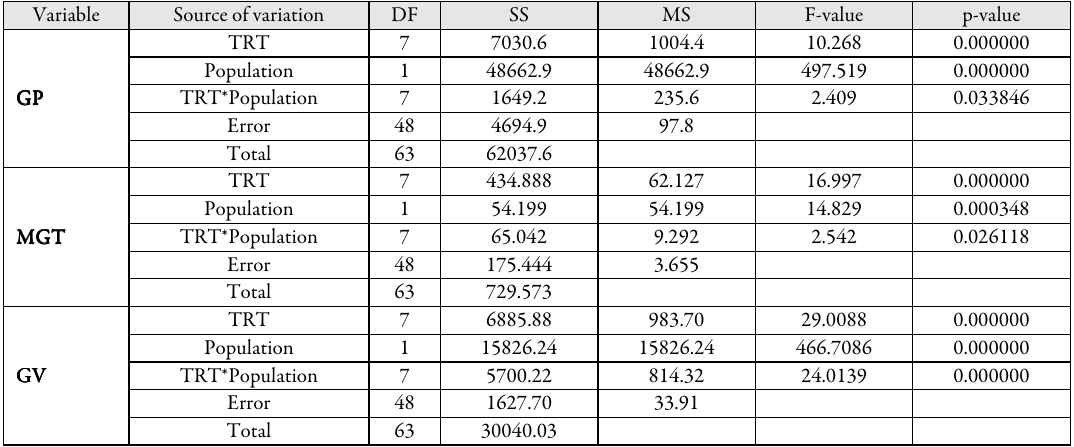
Table 2. Summary of General Linear Model (GLM) multivariate analysis for testing significant effects of seed sources and